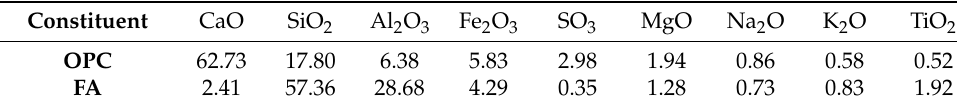
Table 1. Chemical composition of OPC and FA by XRF, wt.%.